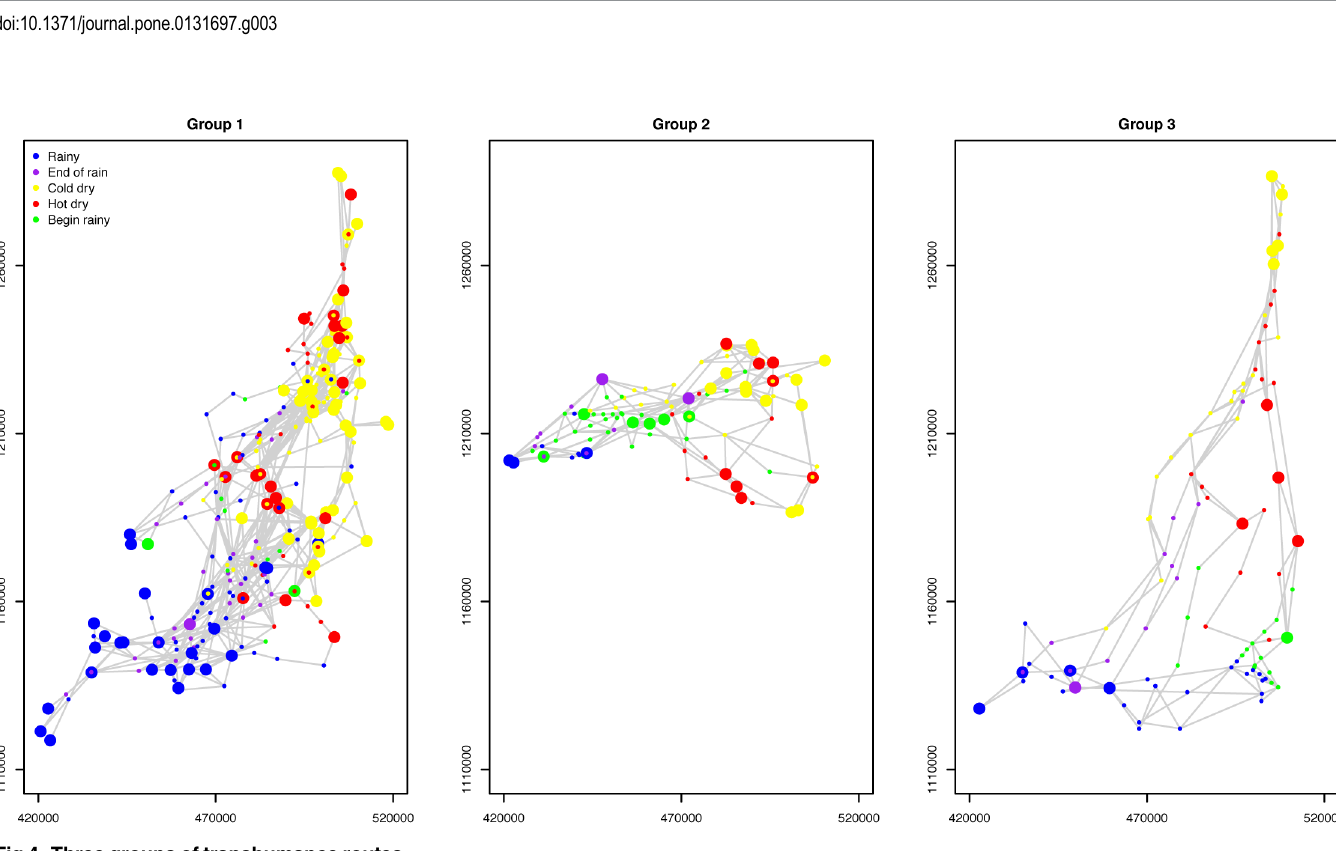
Fig 3. Transhumance routes and seasonality. The map shows all the pastoralists in year 2007 – 2008. Circles represent campsite locations and consecutive sites are linked using straight lines. Large circles represent sojourn campsites ( (cid:1) 20 days). Here the seasons are the time when the pastoralists start the camp. The shaded area shaded is part of the Far North Region.